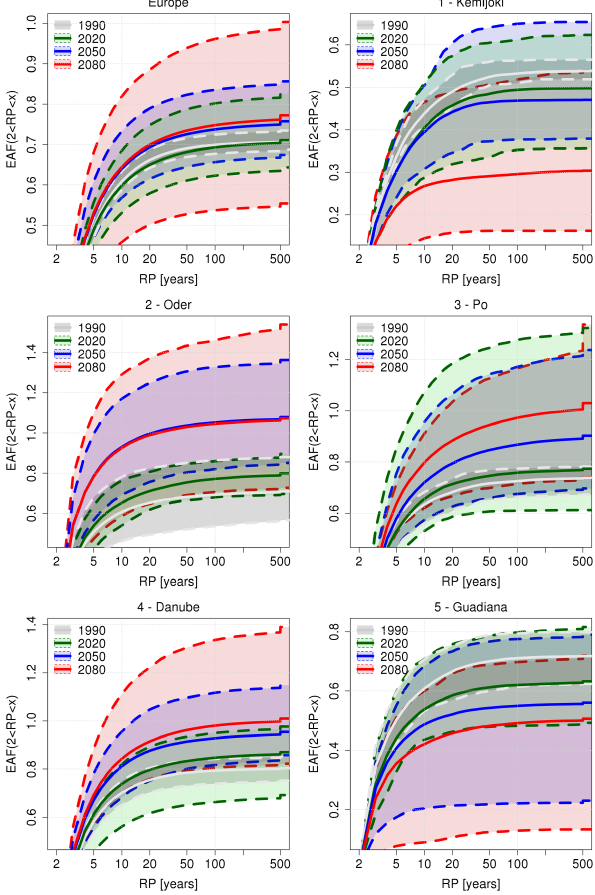
Figure 8. Expected annual frequency of peak flows with return pe- riods larger than 2 years for selected European river basins (see lo- cation in Fig. 1) for the baseline simulation and the three future time